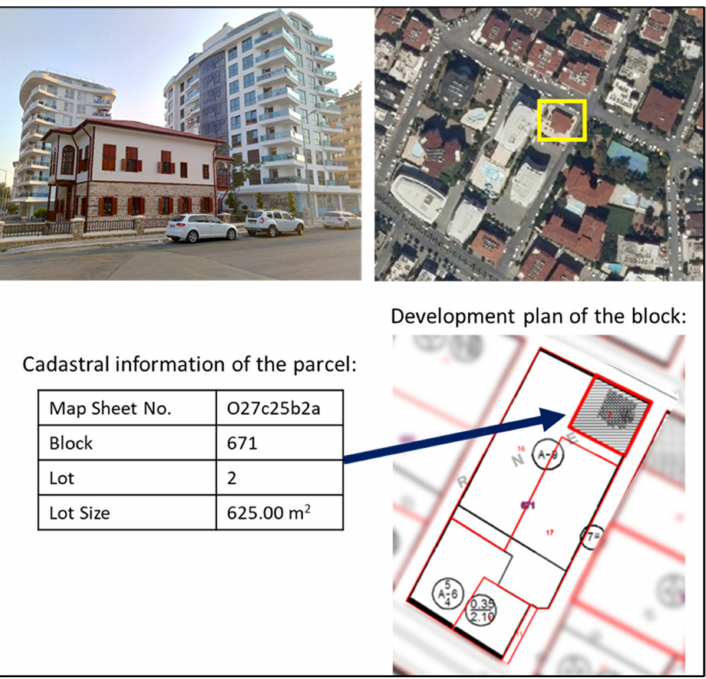
Figure 3. Example of a historic private residence in Alanya. Top left: A side-view of the building (June 2019); top right: A satellite image of the neighborhood; bottom right: development plan of the block; bottom left: cadastral information of the parcel. (For further information, please see Data Availability Statement